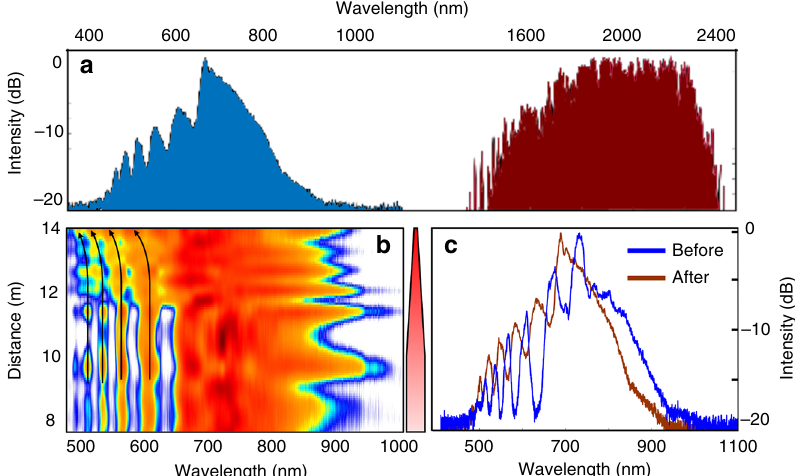
Fig. 2 Experimentally observed spectral evolution in a tapered multimode fi ber. a The spectrum recorded at the output of the tapered multimode fi ber when a 100 fs, 1550 nm pulse is used at the input with a peak power of 750 kW. The NIR frequency components are formed because of multimode solitons (red trace) while the visible part arises from dispersive waves (blue trace). b Spectral evolution in the visible section as measured using a cutback method. The tapered segment of the multimode fi ber is 4 m long (its core radius is reduced from 40 to 10 µ m) and is preceded by a 10 m uniform fi ber. As the pulses enter the tapered section, dispersive waves experience a continuous blue-drifting of more than 45 nm, indicating a speedup in the intermodal oscillations. The tapered multimode fi ber is depicted on the right side, where the darker red color represents an increase in the light intensity in the fi ber due to a decrease in core size. c The spectrum in b is depicted for comparison, before and after the tapered section where blue-shifting of the dispersive wave